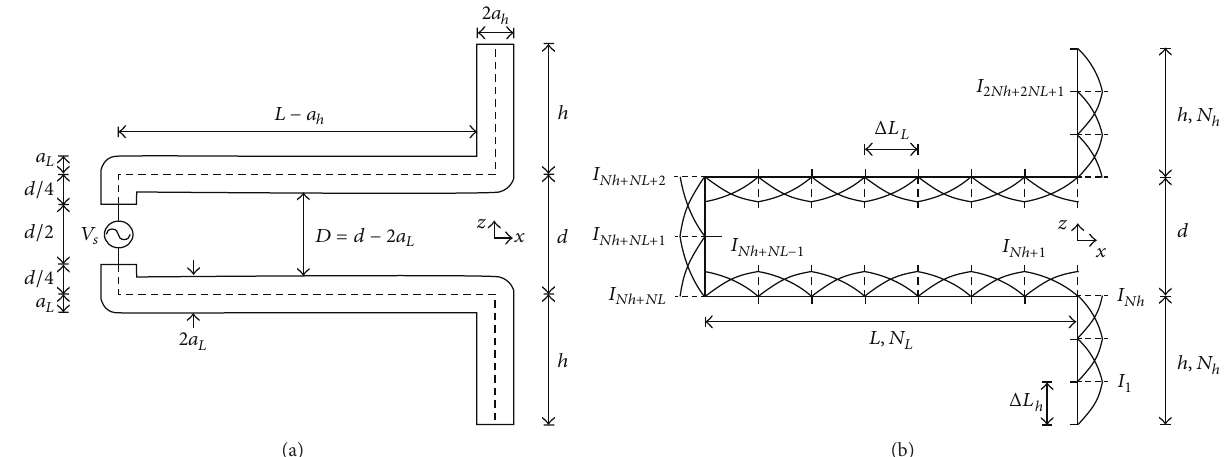
Figure 1: Cylindrical plasmonic nanocircuit composed of voltage source, optical transmission line, and nanodipole. (a) Geometry of the problem. (b) Discretization used in MoM